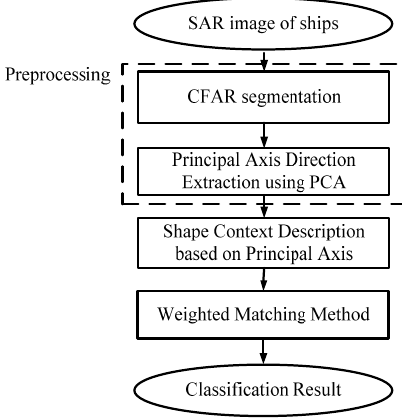
Figure 2. The procedure of classification algorithm.